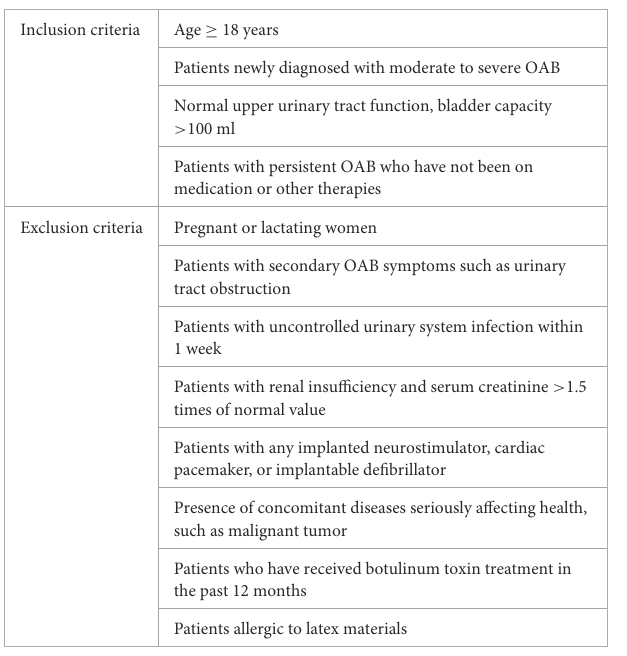
TABLE 1 The inclusion and exclusion criteria. Inclusion criteria